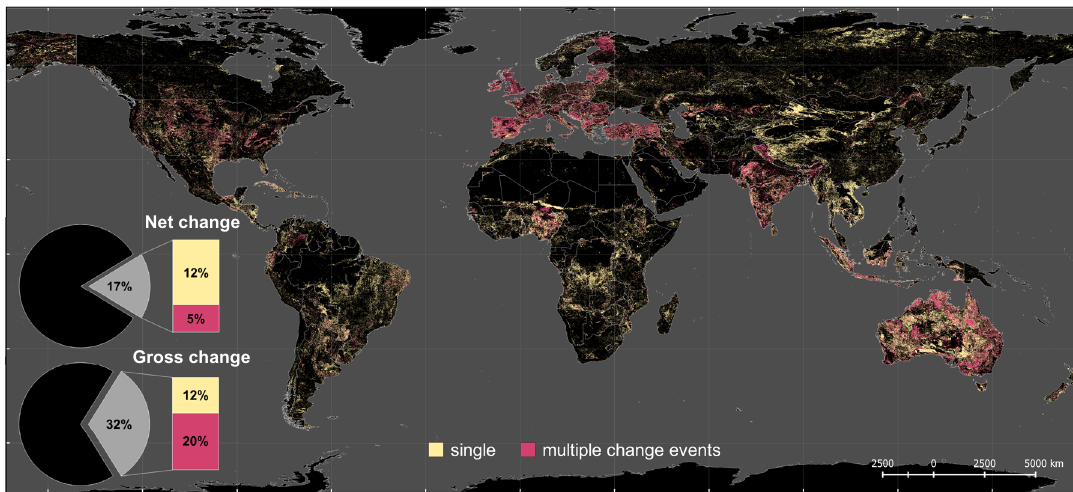
Fig. 1 Spatial extent of global land use/cover change. Share of the total land surface without (net change) and with consideration of multiple changes (gross change) between six major land use/cover categories (urban area, cropland, pasture/rangeland, forest, unmanaged grass/shrubland, non-/sparsely vegetated land) in 1960 – 2019. The spatial extent of land use/cover change is displayed in yellow (areas with single change events) and red (areas with multiple change